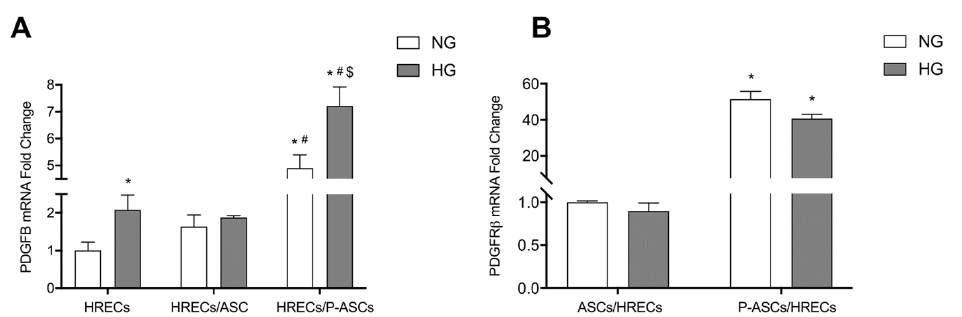
Figure 6. Evaluation of the PDGF-B/PDGFR- β axis in cultures of human retinal endothelial cells (HRECs) alone and co-cultured with human adipose-derived mesenchymal stem cells (ASCs) or pericyte-like ASCs (P-ASCs). By qRT-PCR, PDGF-B RNA levels were measured from HRECs (panel A ) and PDGFR- β mRNA levels were measured from ASCs or P-ASCs (panel B ). Cell samples that were cultured either in normal glucose (NG) or high glucose (HG) conditions were evaluated. mRNA levels of each group were normalized to the housekeeping reference gene ribosomal 18S RNA. Although the PDGF-B RNA levels were increased in cultures of HREC alone by glucose addition, much more evident increases were obtained when P-ASCs were also present, both in NG and HG conditions. On the other hand, when detecting PDGFR- β RNA levels in ASCs or P-ASCs, basal values observed in ASCs were greatly increased in P-ASCs, both in NG and HG conditions. Data indicate that enhanced pericyte recruitment would occur if P-ASCs are present. Each value represents mean ± SEM obtained from three independent experiments. Panel A : * p < 0.05 vs. HRECs in NG; # p < 0.05 vs. HRECs in HG; $ p < 0.05 HRECs/P-ASCs in HG vs. HRECs/ASCs in HG. Panel B : * p < 0.05 vs. the corresponding co-culture in